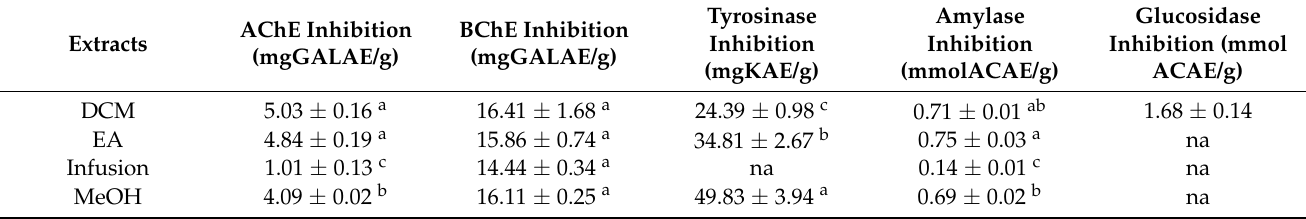
Table 5. Enzyme inhibitory properties of the tested extracts